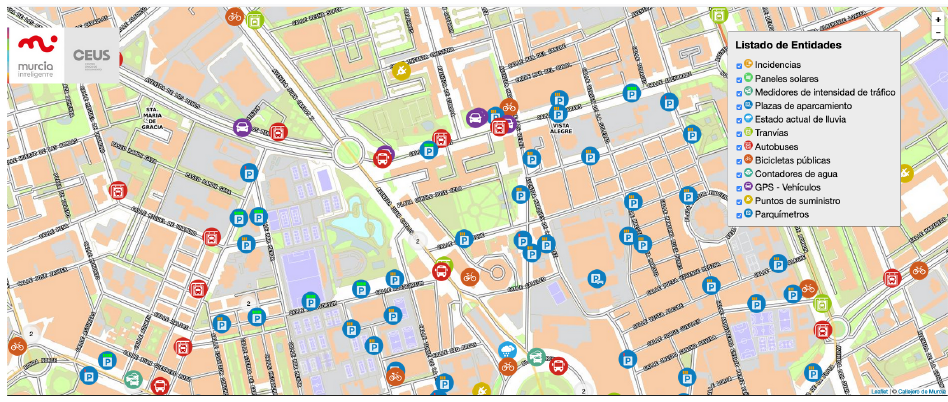
Figure 2. MiMurcia